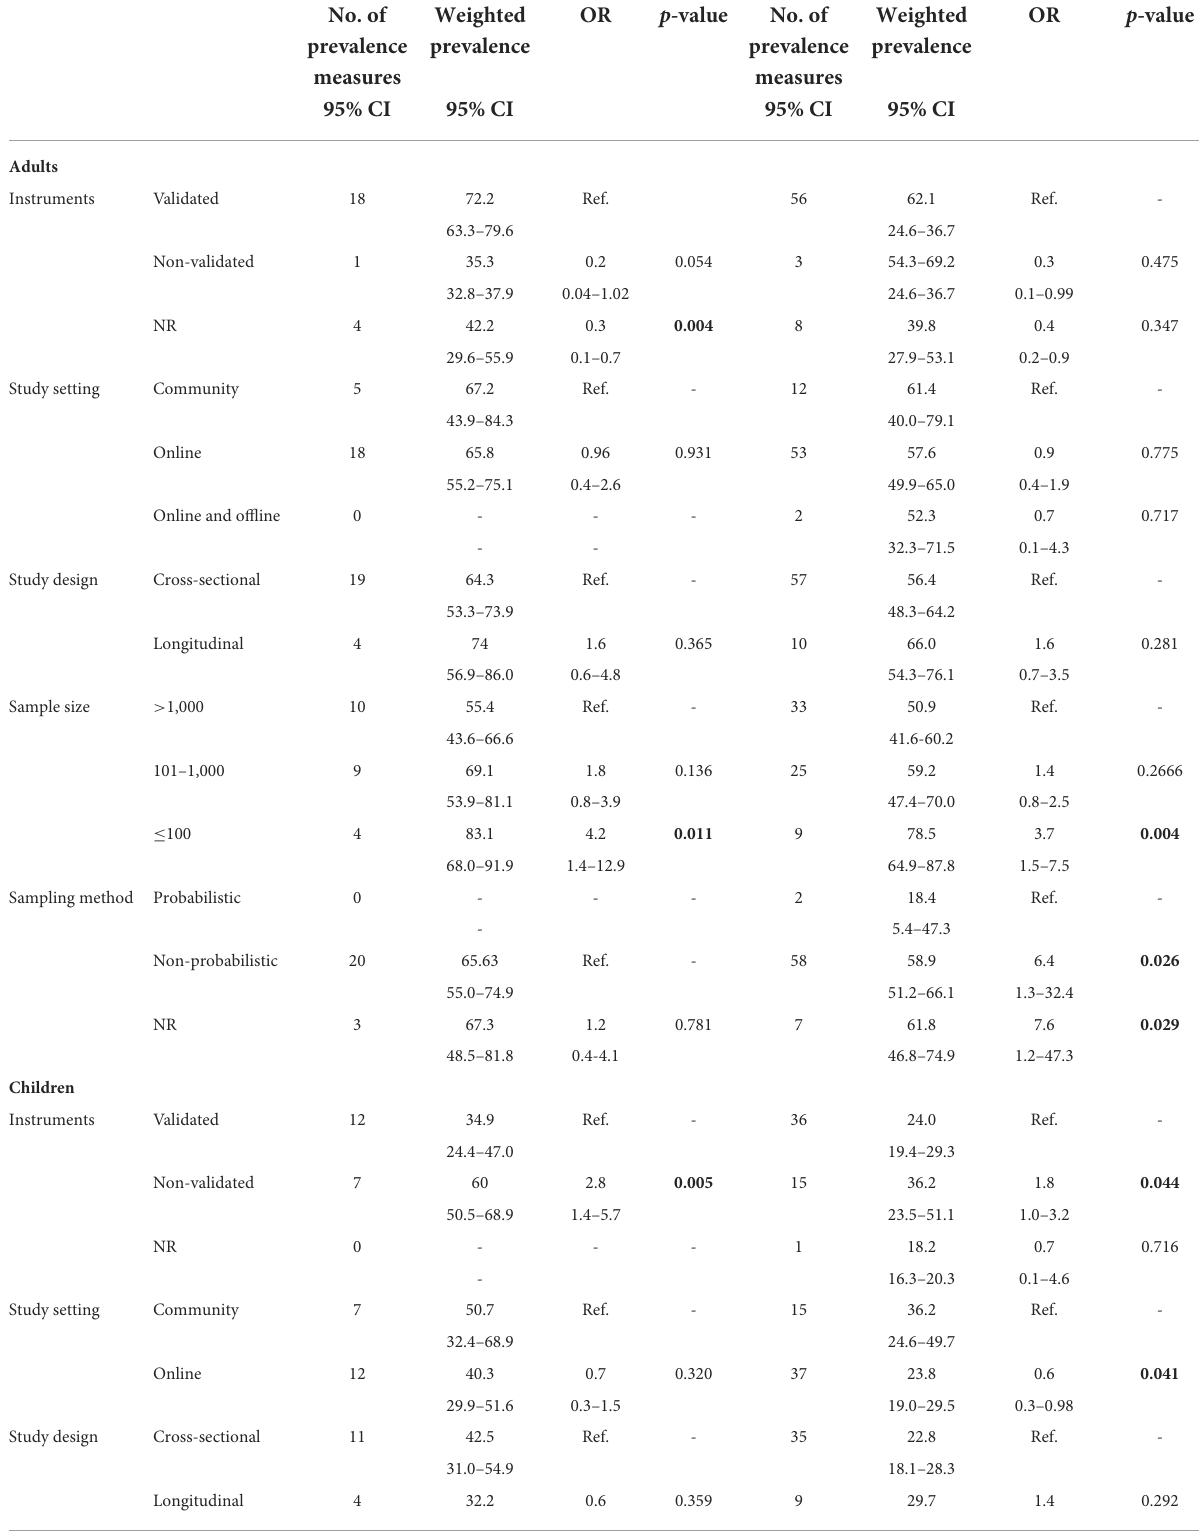
TABLE 3 Univariate meta-regression models for physical activity prevalence in adult and child general populations.